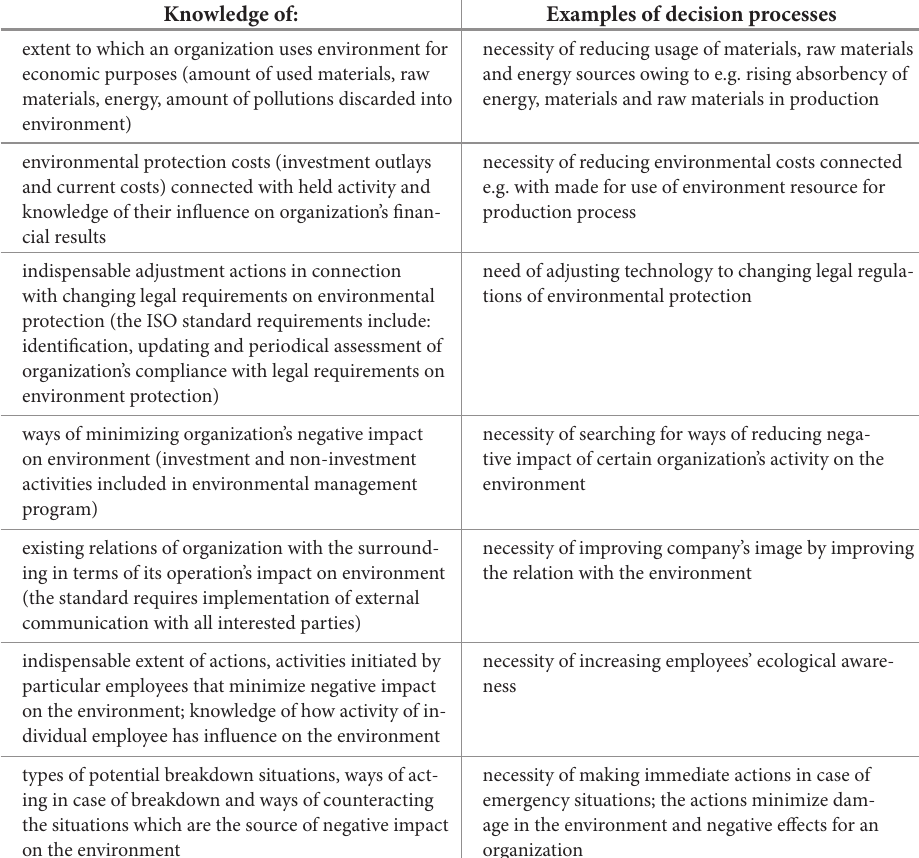
Table 6. Examples of decision processes using acquired environmental knowledge within environmental management